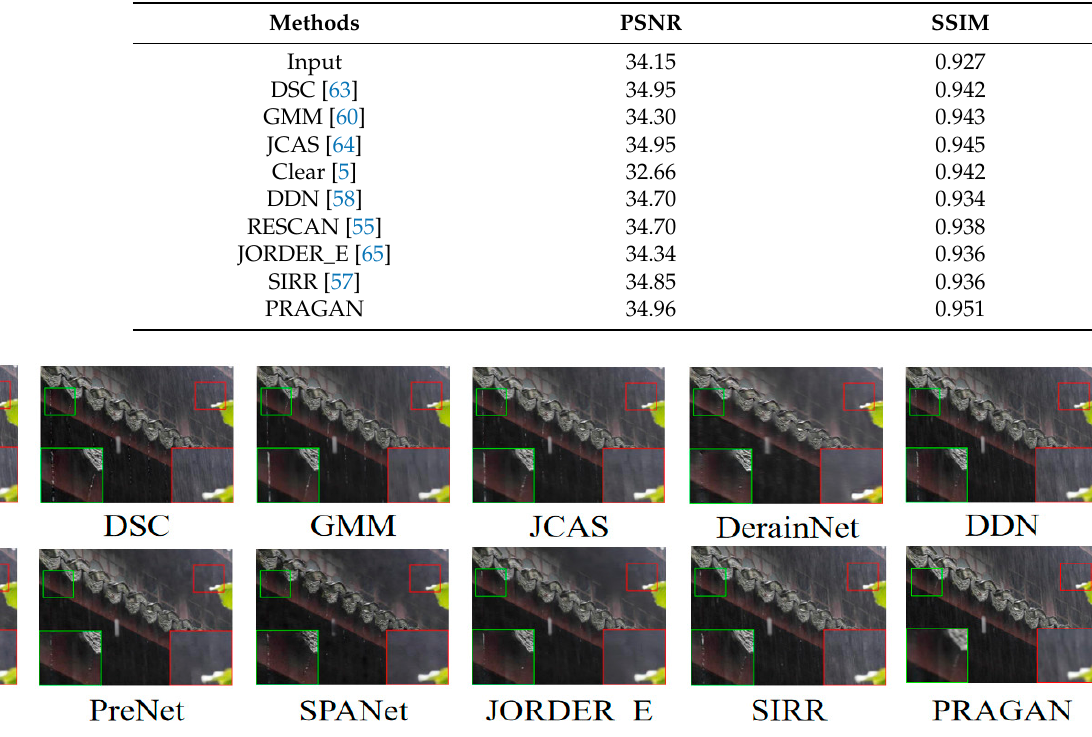
Figure 10. Deraining results on Internet-Data [57] testing set. Best viewed when zoomed in and in color.